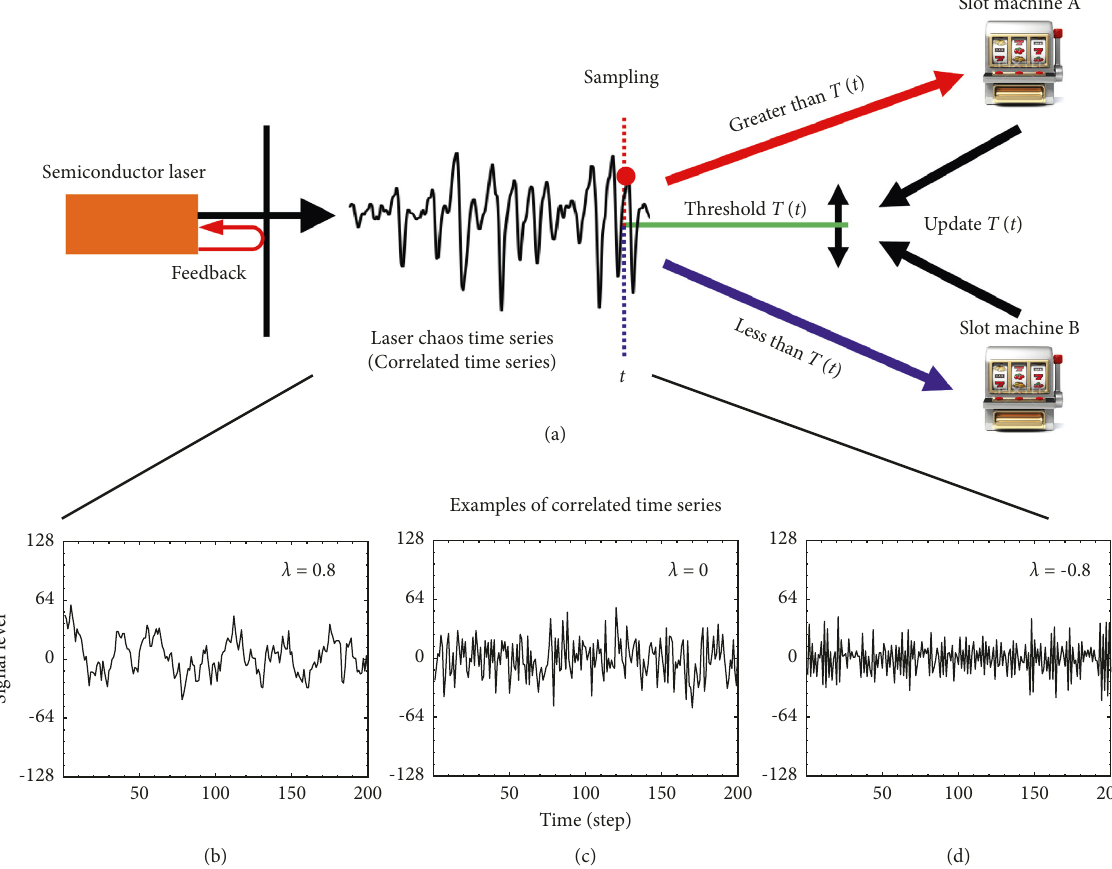
Figure 1: (a) Decision-making architecture using laser chaos time series or correlated time series. (b–d) Snapshots of correlated time series generated via Fourier transform surrogate. The correlation is specified by the parameter λ . (b) λ � 0.8 (strong positive autocorrelation), (c) λ � 0 (zero correlation), and (d) λ �− 0.8 (strong negative